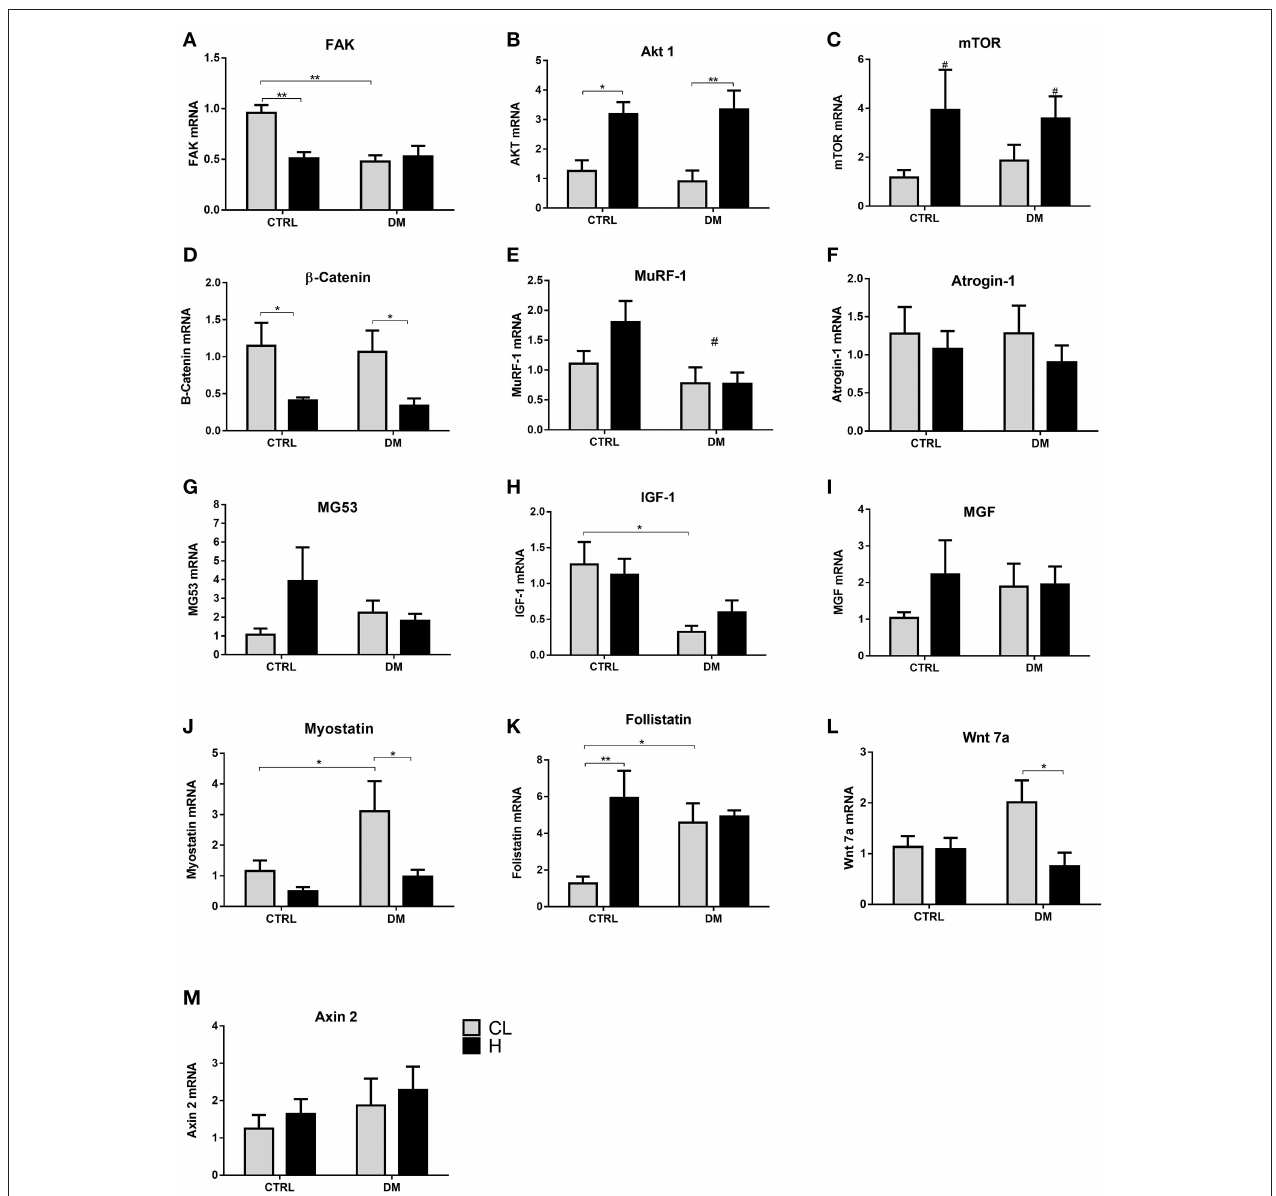
FIGURE 6 | (A,B,D, F–M) mRNA expression of several genes in the EDL muscle after 7 days of overload. Results are presented as mean ± SEM of at least six animals. Results were analyzed using two-way ANOVA followed by Bonferroni post-test. * p < 0.05, ** p < 0.01. In (C) , # p < 0.05 for CTRL-CL/DM-CL vs. CTRL-H/DM-H, in (E) , # p < 0.05 for CTRL vs. DM using two-way ANOVA only. CL, Contralateral muscle; H, Hypertrophied muscle; DM, Diabetic group; CTRL, Control